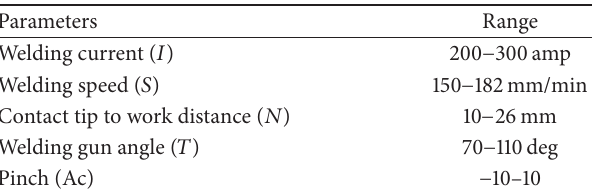
Table 10: GA search ranges.